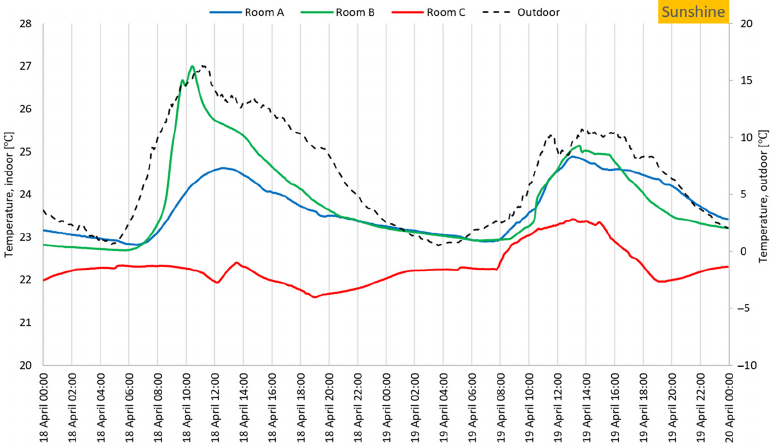
Figure 22. Comparison of temperature outdoors and indoors in all three rooms for 2 days when it was sunny outside. The indoor temperature of the three rooms is shown on the left axis, and the outdoor temperature is shown on the right axis.